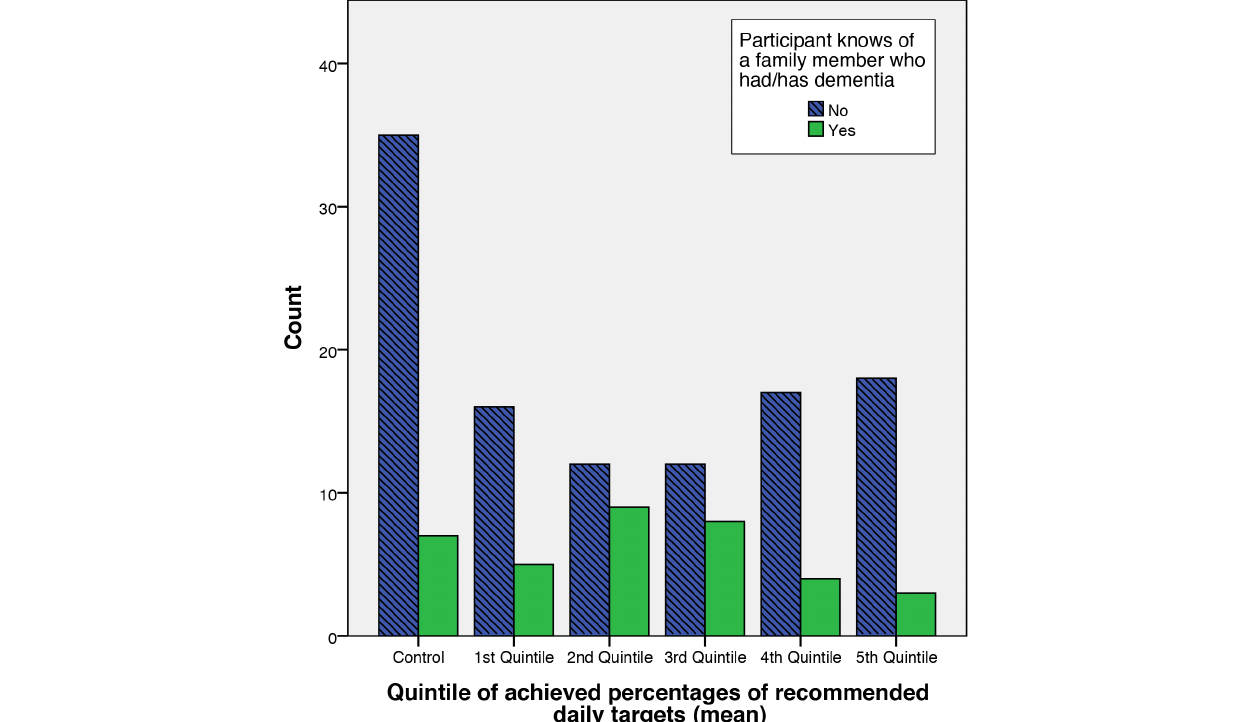
Figure 10. Bar chart showing the log performance quintiles against the number of users who report to have known of a family member having/had